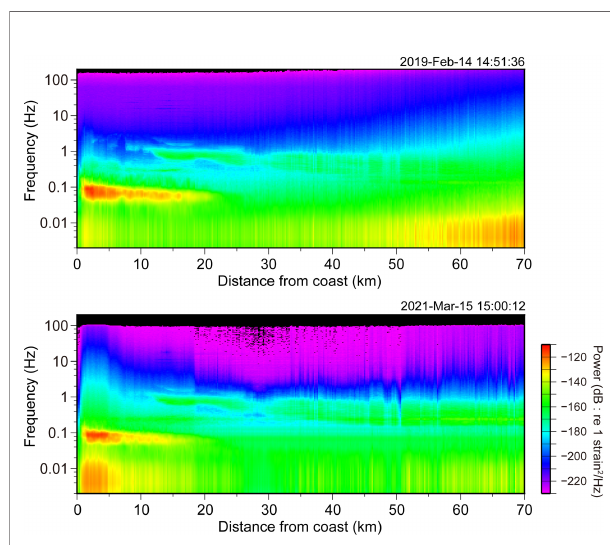
FIGURE 7 | Spatial variation of ambient noise spectra on the sea fl oor obtained by the DAS measurements in February 2019 (upper) and March 2021 (lower). The horizontal axis is the distance from the coast, and the vertical axis shows frequency. There were large noises around a period of 15 s near the coast.